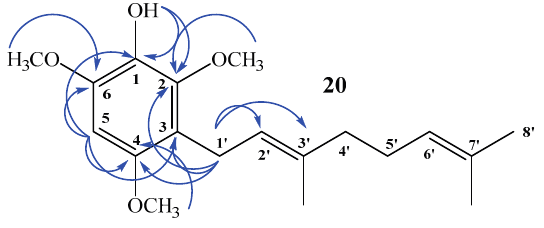
Figure 6. Main correlations 2D 1 H– 13 C HMBC for compound 20